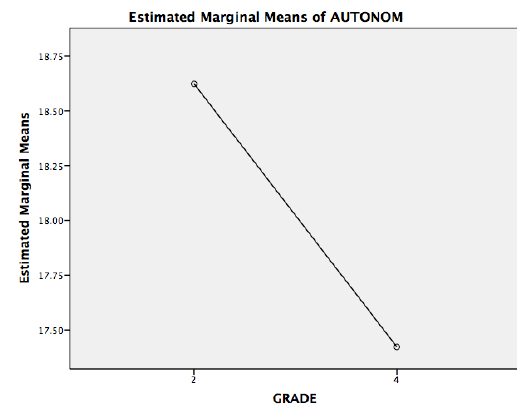
Figure 3. Profile plot of autonomy